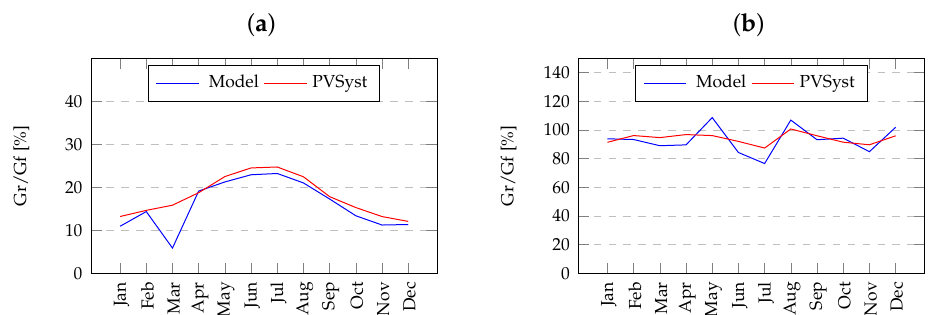
Figure 13. Estimated model comparison vs. the PVSyst Gr/Gf % gain from Jan to Dec for the ( a ) tilted SN orientation and ( b ) vertical EW orientation,